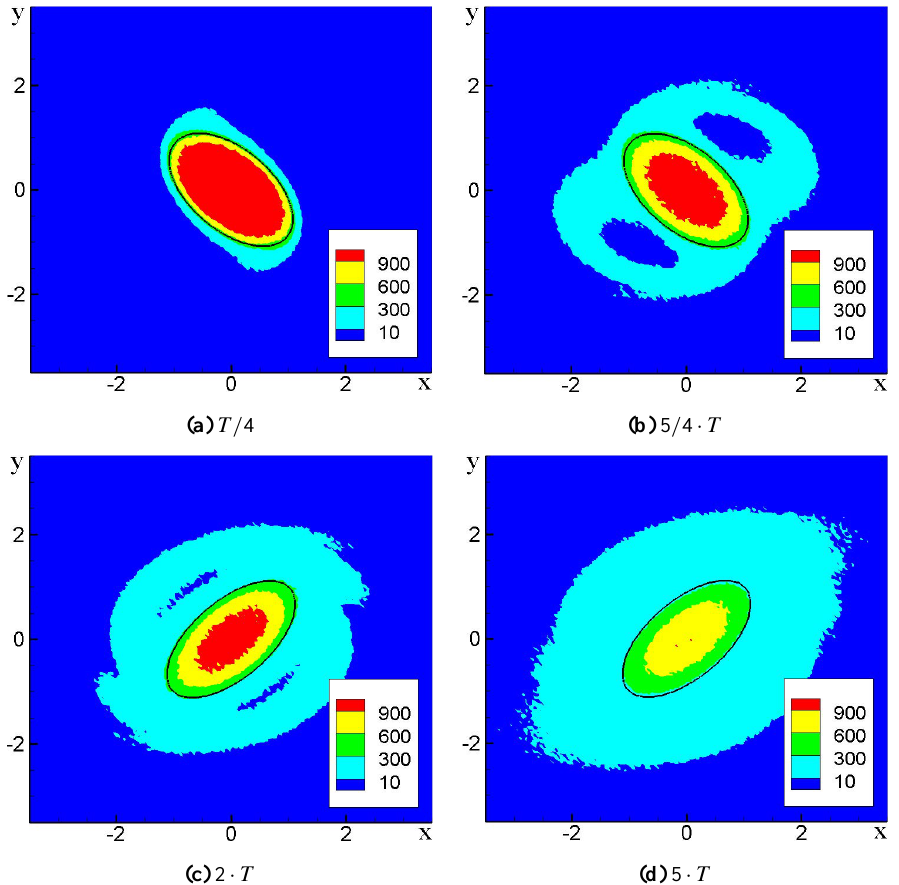
Fig. 5. Scalar concentration field at the indicated time as κ = 10 − 2 corresponding to the parameters as in Fig. 2a. The bold black curve is the vortex’s boundary corresponding to the initial scalar distribution. Concentration (number of markers) is shown by